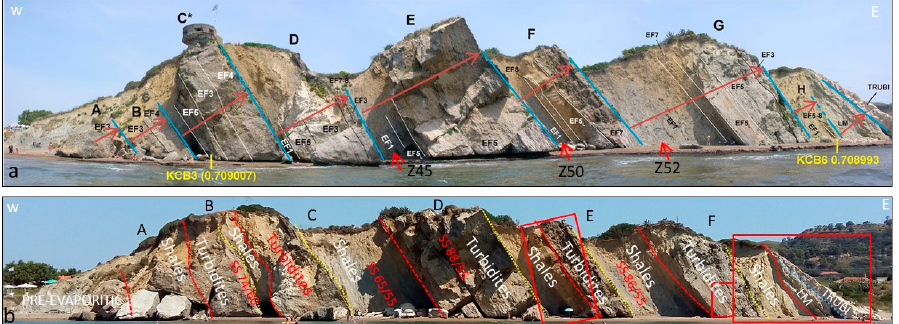
Figure 5. The Kalamaki section into two interpretations. ( a ) [29] where we add the position of the three samples from Mpotziolis et al. [24] with which the Early Pliocene age was determined for this part of the Kalamaki section. ( b ) The new interpretation of the same section with additional data. Bed directions were added and the cycles with evaporites and shales re-organized.